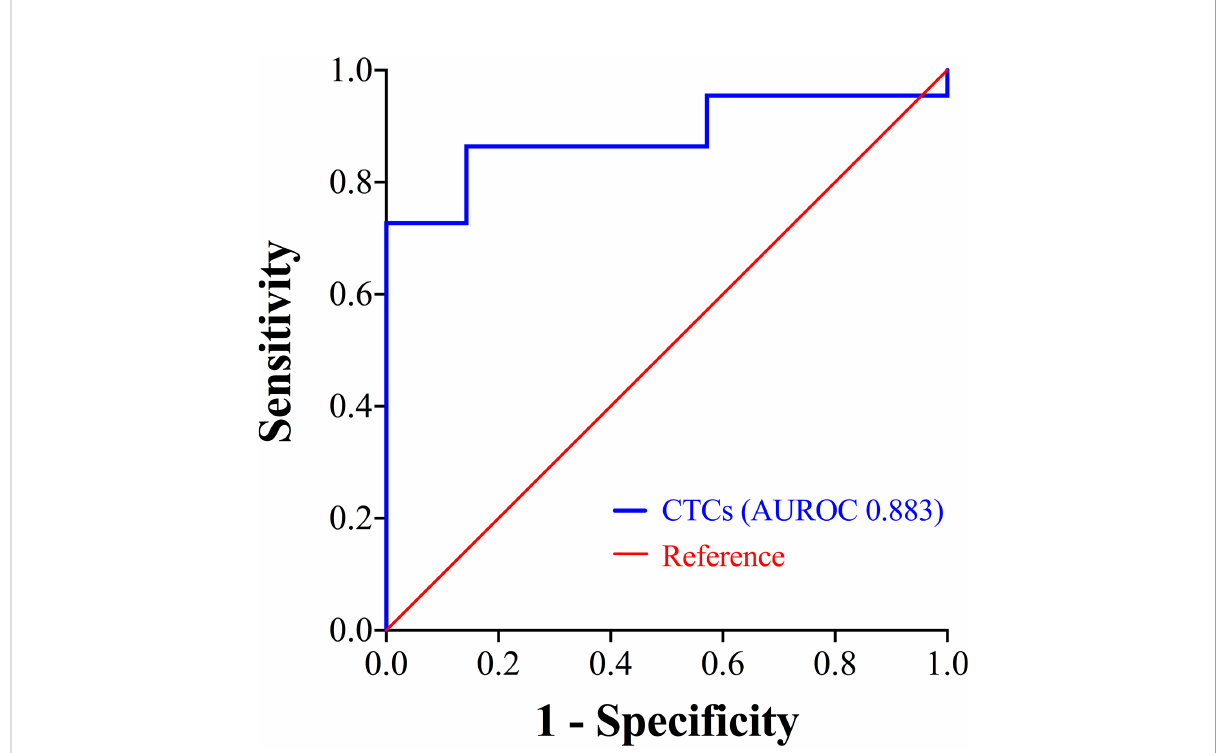
FIGURE 2 ROC curve showing the prognostic strati fi cation performance of CTCs. CTCs, circulating tumor cells; ROC, receiver operating characteristic; AUROC, area under the ROC